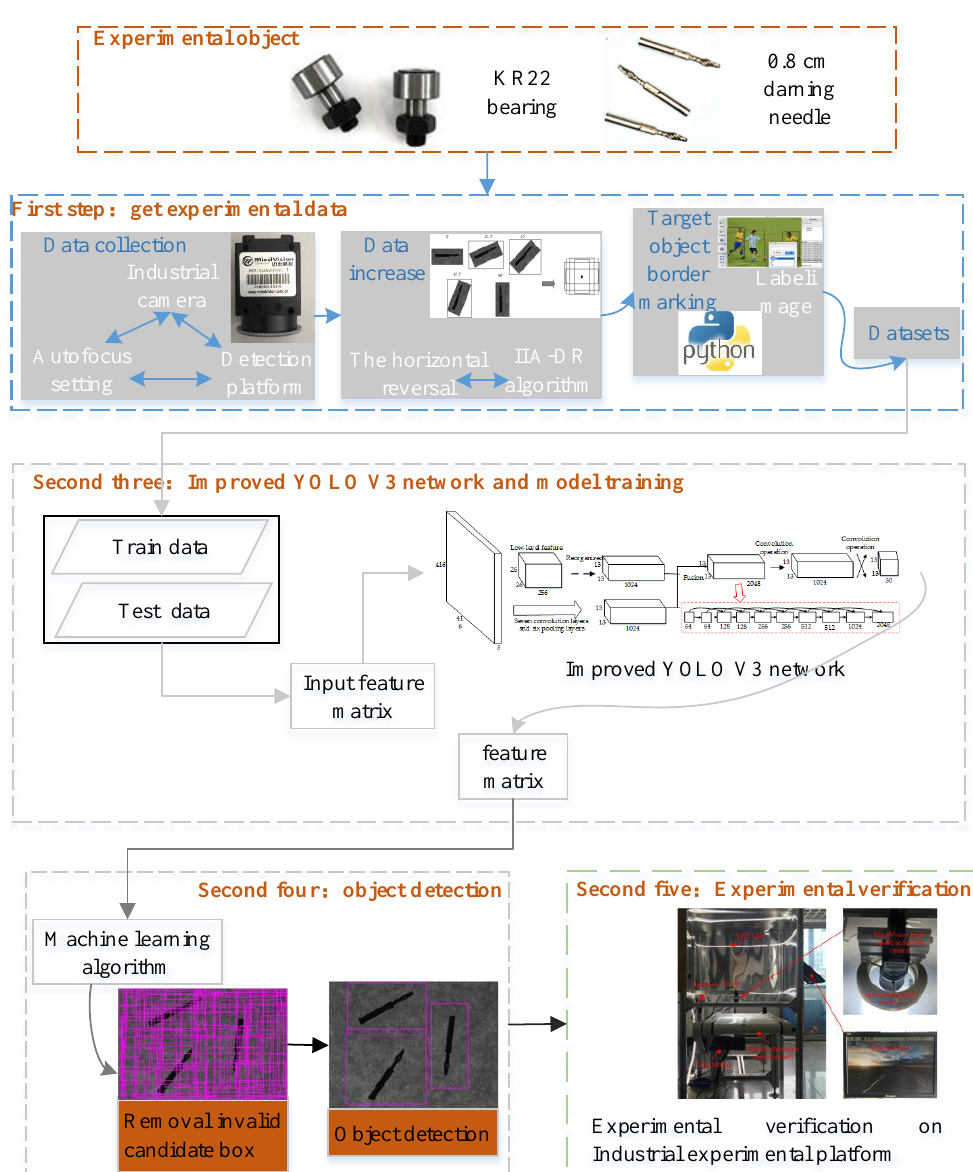
Figure 1. Technical flowchart of the study.